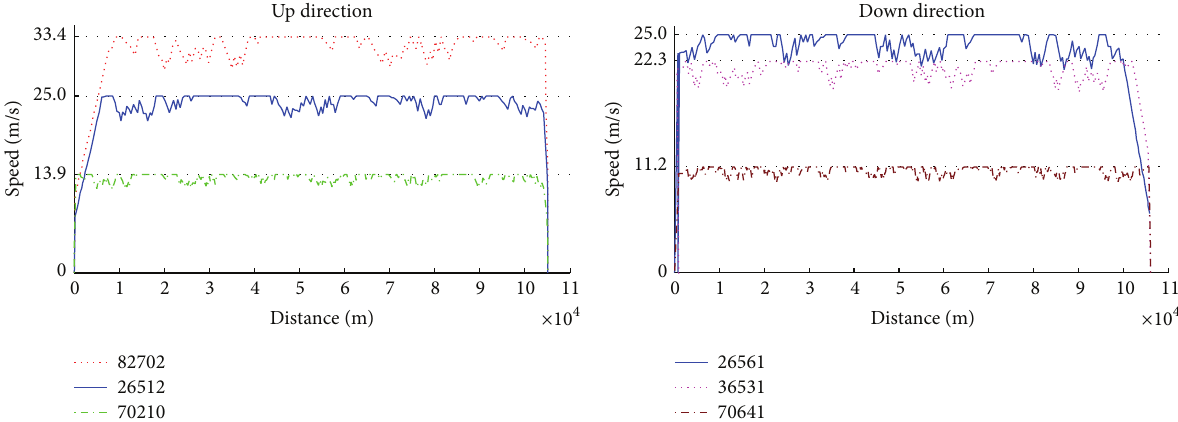
Figure 11: Train speed-distance curve (NCBS number: